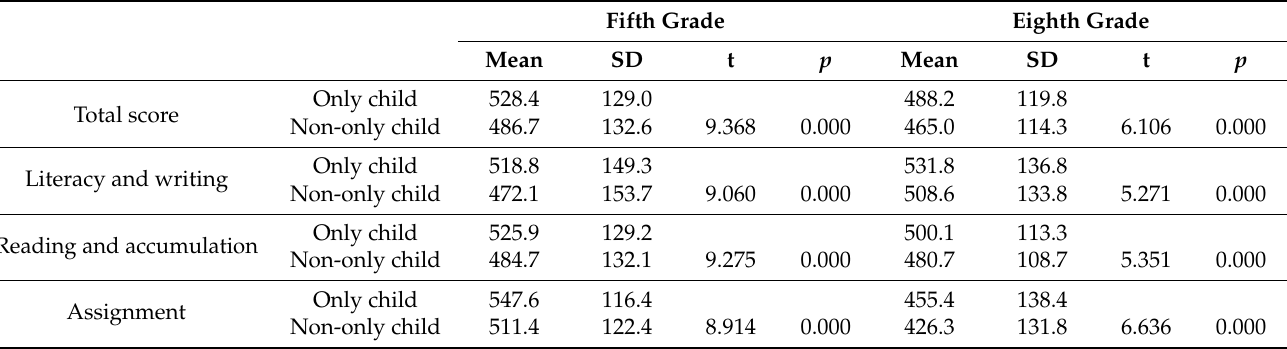
Table 3. Academic performance dimensions before